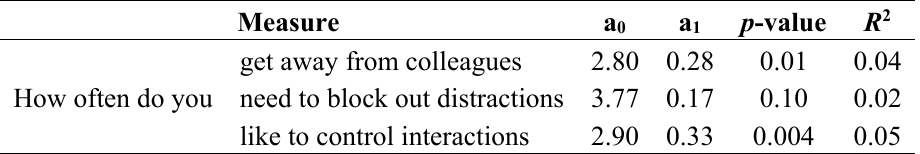
Figure 5. How the need to carry out privacy behaviours changes for people who work in different numbers of places. People who spend less time in the office feel a greater need to control interactions. Table 7. Summary of regression model between the number of alternative work locations and the need to carry out privacy